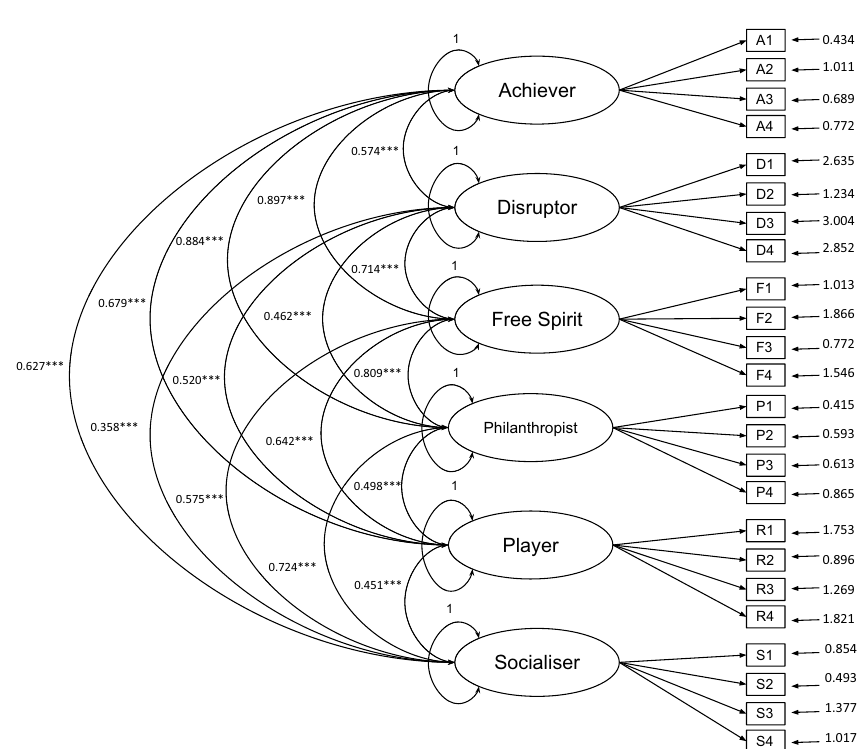
Figure 2. Path model with correlations between the factors. The ellipses represent the factors and the rectangles represent the items of the scale. *** p < 0.001 . The variance in each factor is defined in 1 by JASP 26 . All parameters were freely estimated in the